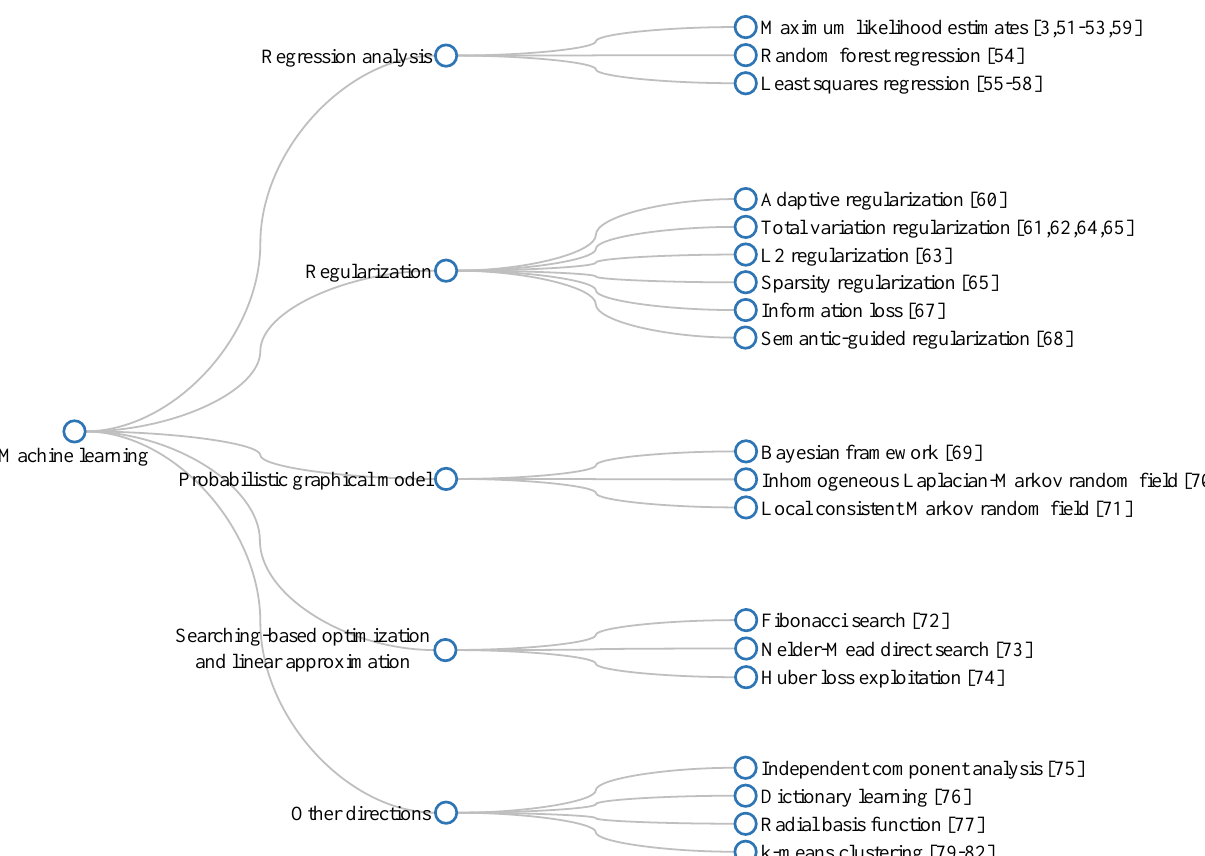
Figure 10. Branching diagram summarizing machine-learning-based dehazing